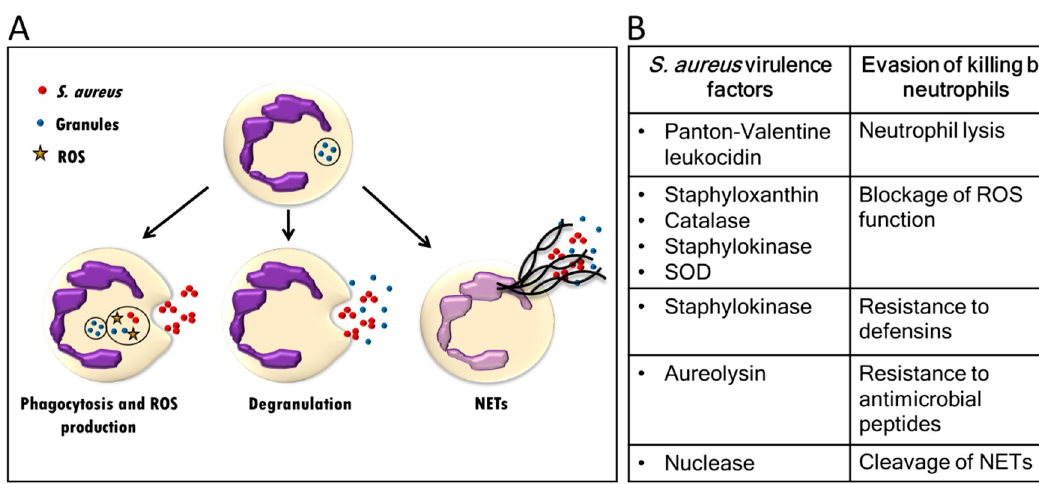
Figure 2. Killing of S. aureus by neutrophils and immune evasion. ( A ) Neutrophils phagocytose S. aureus and kill the bacteria by the production of ROS, liberation of lytic enzymes from granules and production of NETs. ( B ) S. aureus may possess virulence factors including enzymes that kill neutrophils or allow the bacteria to evade killing by neutrophils. ROS: reactive oxygen species; NET: neutrophil extracellular traps; SOK: surface factor promoting resistance to oxidative killing; SOD: superoxide dismutase.